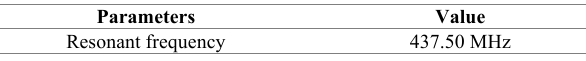
Table VI . Calculated parameters of Masat-1 half-wave dipole initial